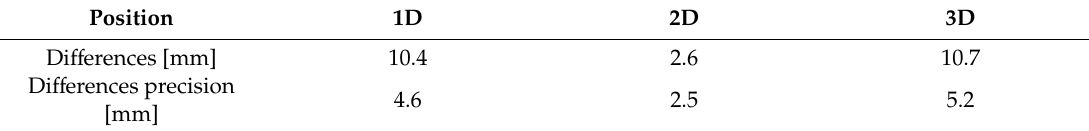
Table 6. Di ff erences of 1D, 2D, and 3D positions from G-baseline and L-baseline.